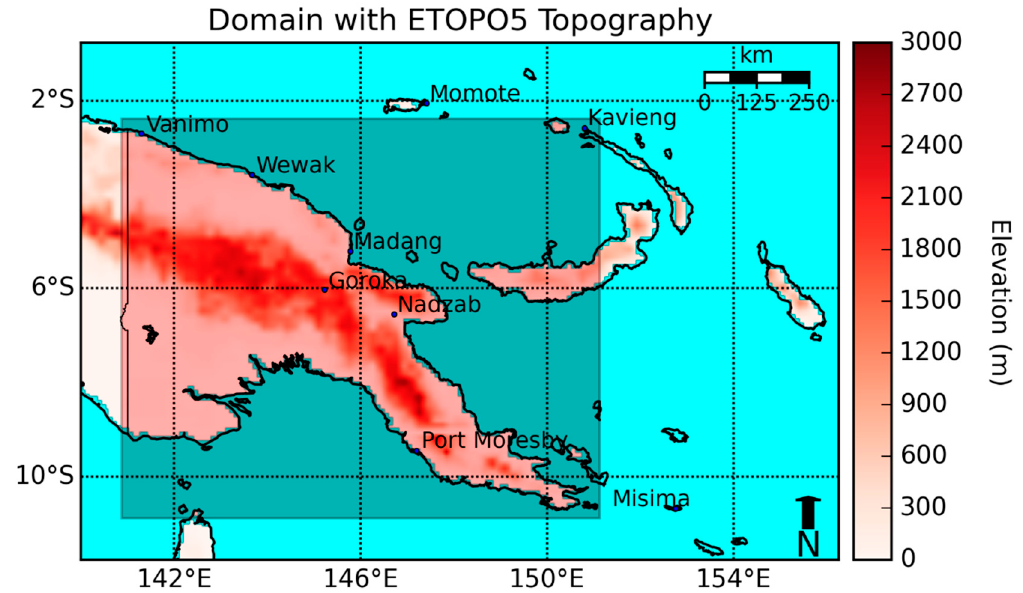
Figure 1. The domain of analysis, stations marked as the blue dots, the reduced domain used in Section 3.2.7 is also marked as the darker rectangle.